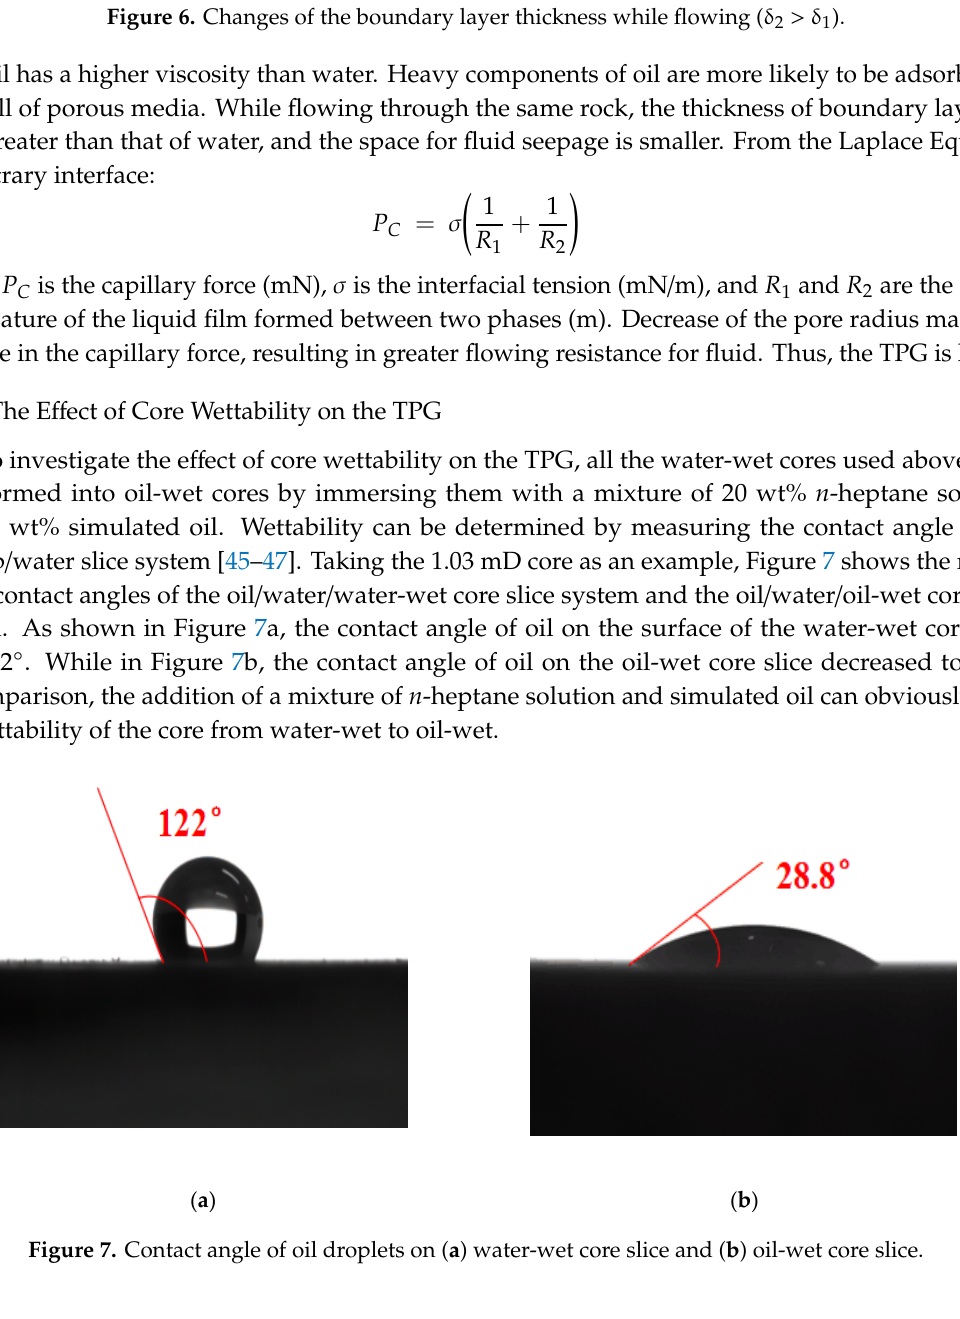
Figure 6. Changes of the boundary layer thickness while flowing ( δ 2 > δ 1 ).